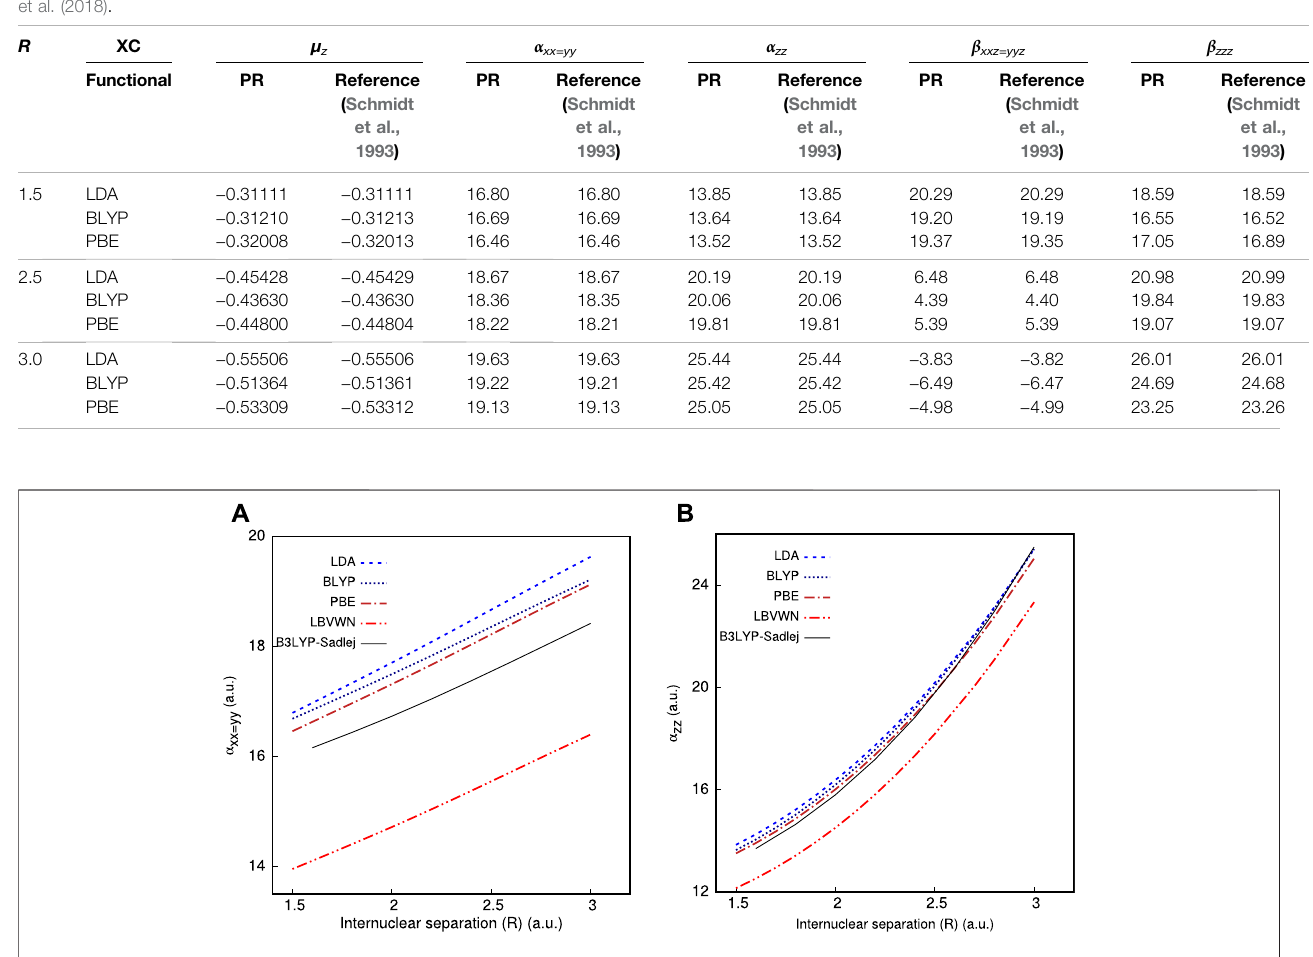
FIGURE 1 | Impact of R on (A) α xx = yy and (B) α zz of HCl molecule, taken from Ghosal et al. (2018).